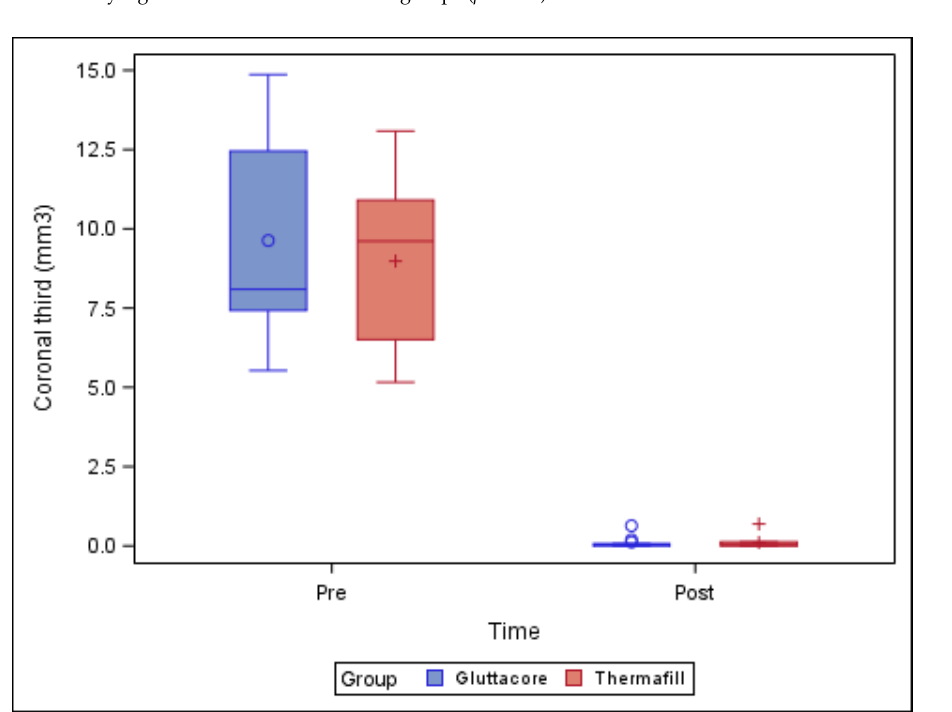
Table 2. Descriptive analysis of the pre-operative root canal filling material volume (mm 3 ) and the remaining post-operative root canal filling material volume (mm 3 ) at the middle third of the root canal systems.